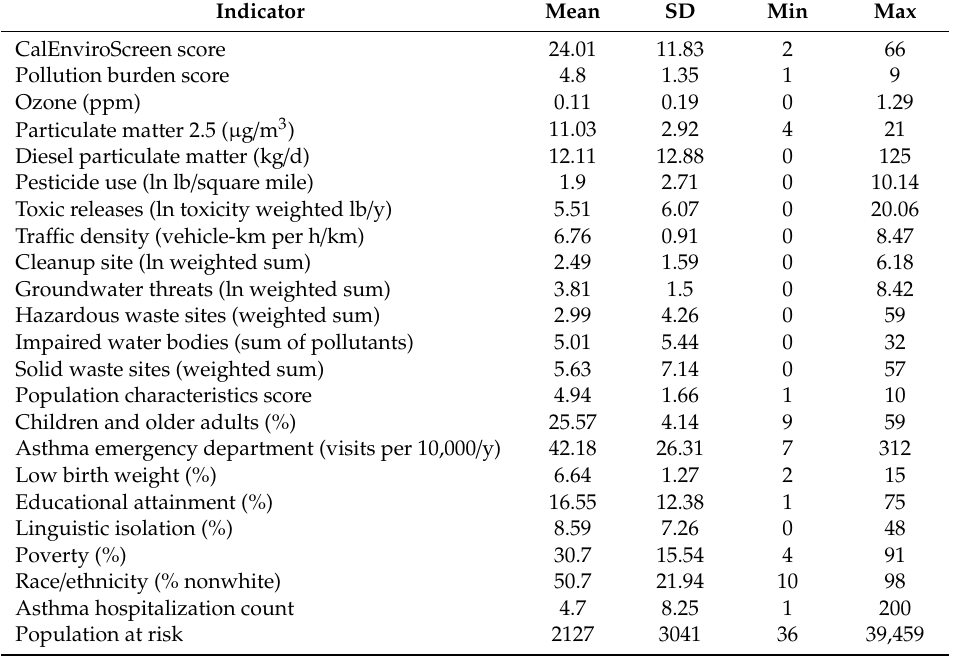
Table 2. Descriptive statistics across zip codes (n = 901) of CalEnviroScreen version 1 and outcome of interest, 2010–2012,